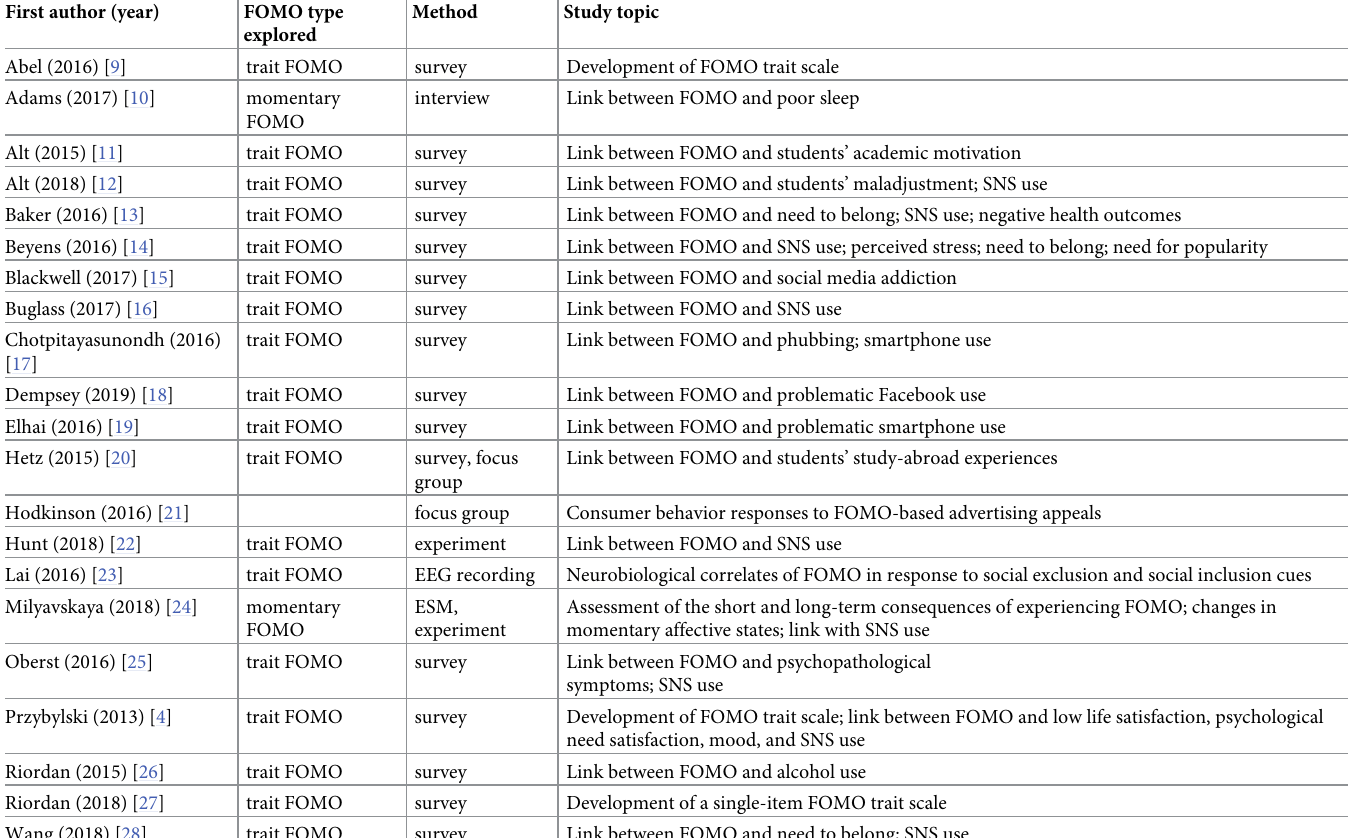
Table 1. Summary of previous academic work on